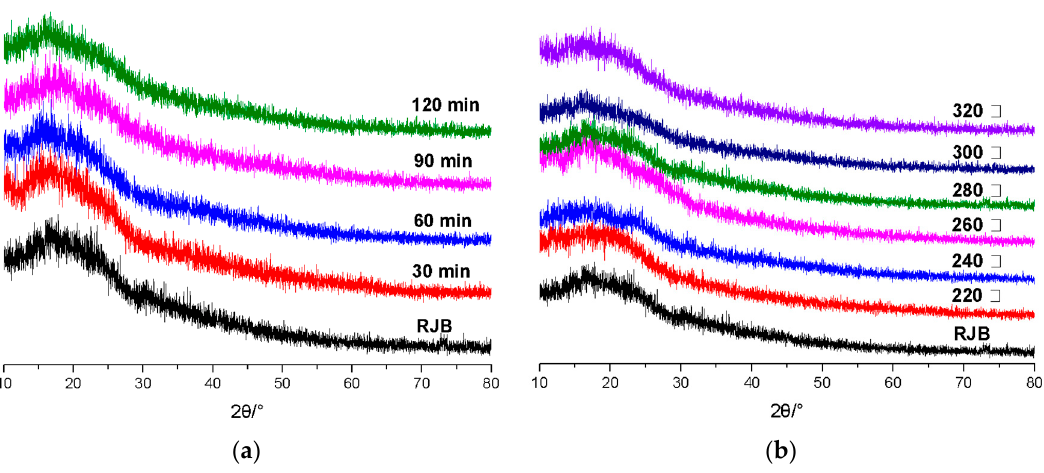
Figure 3. XRD spectra for RJB and hydrochar produced by HTC. ( a ) Residence time; ( b ) reaction Figure3. XRDspectraforRJBandhydrocharproducedbyHTC.( a )Residencetime;( b temperature.